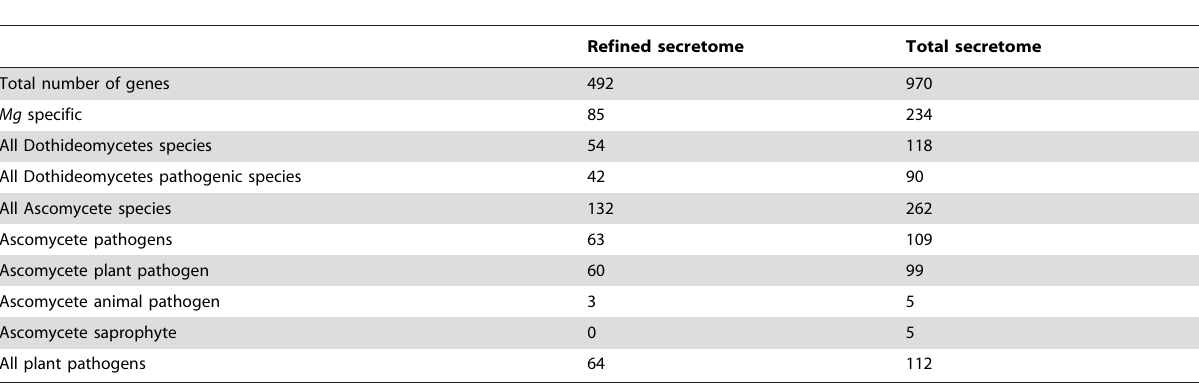
Table 11. Conservation of the M. graminicola ( Mg ) genes, predicted to encode secreted proteins, amongst the 124 fungal, oomycete and Chytrid genomes assessed and then presented according to overall species distribution or lifestyle.